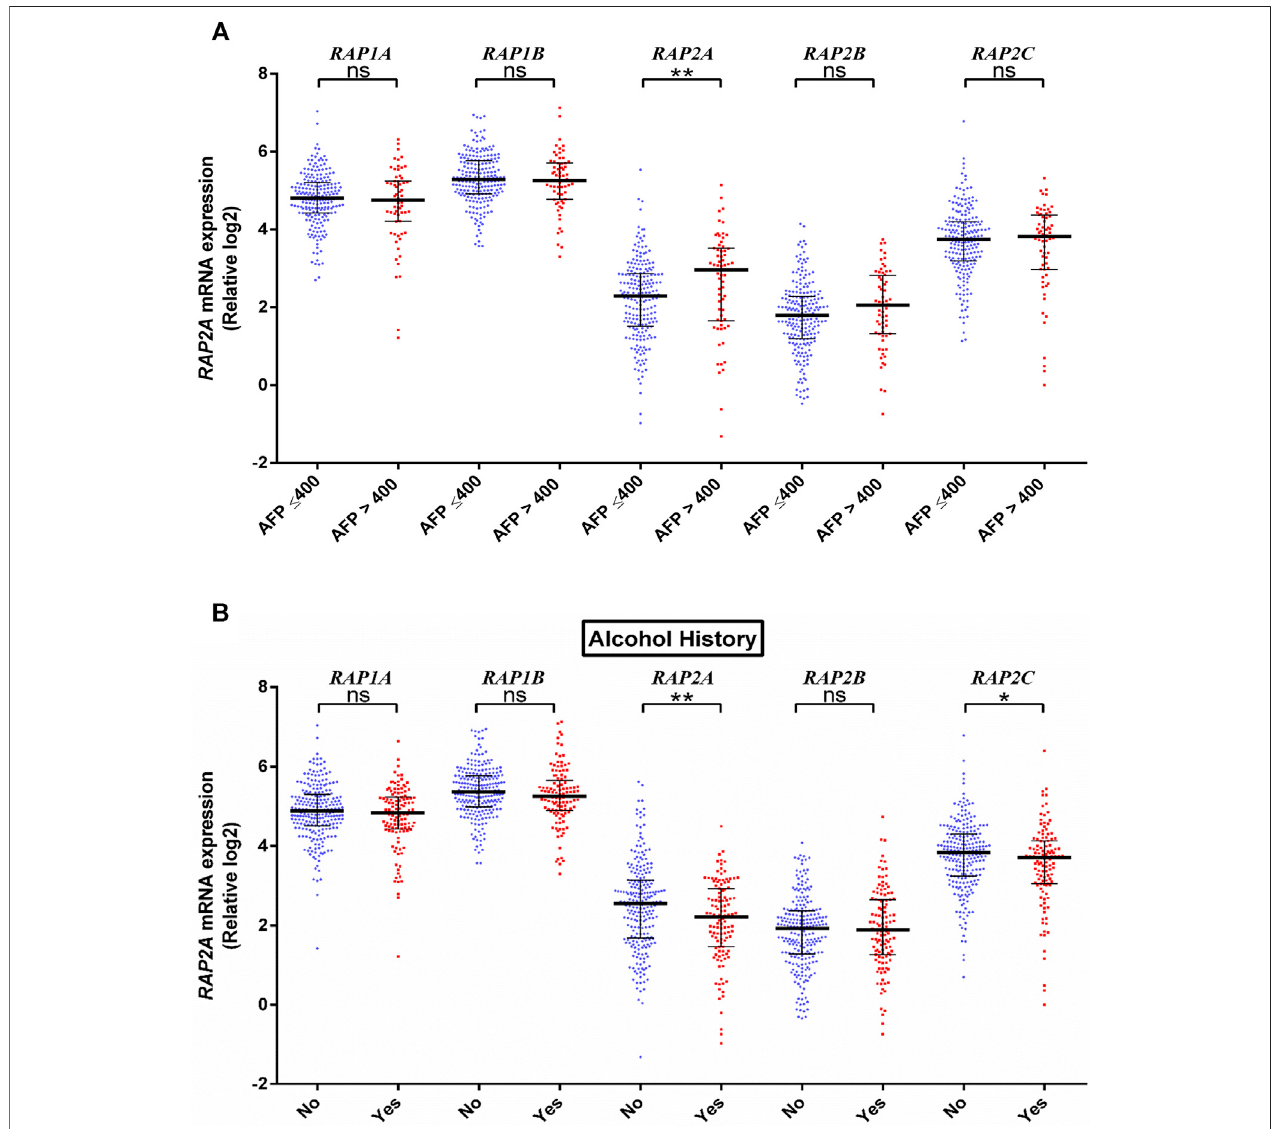
FIGURE 4 | Association of RAP expression in TCGA-KIRC dataset with (A) AFP levels, and (B) alcohol history. **** p < 0.0001; *** p < 0.001; ** p < 0.01; * p < 0.05; ns, p > 0.05.